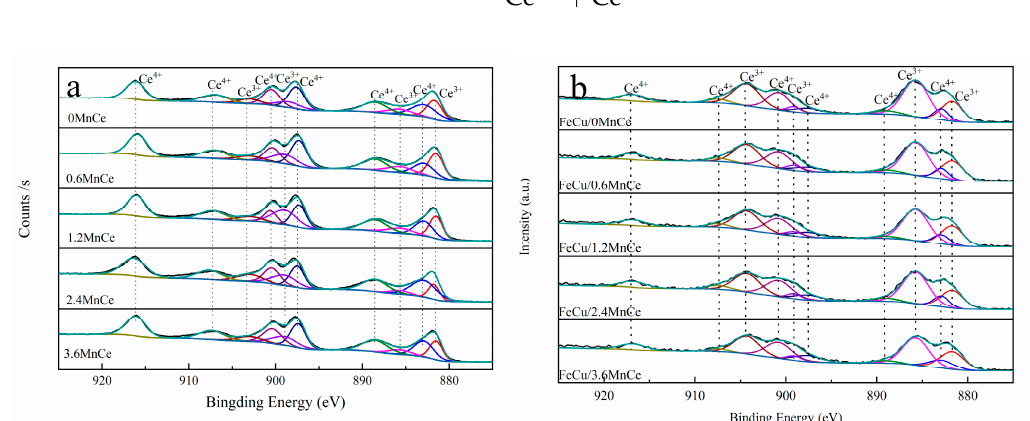
Figure 3. Ce 3d XPS spectra: ( a ) fresh supports, ( b ) used catalysts.